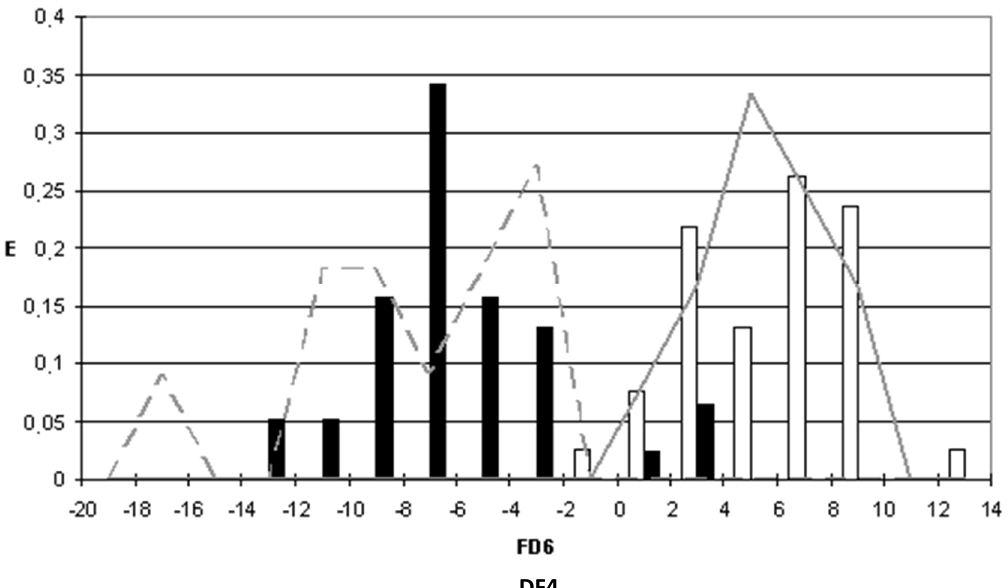
Figure 4. DF4 pharmacological distribution diagram. Black bars: Training Inactives. White bars: Training Actives. Dashed line: Test Inactives. Straight line: Test Actives.